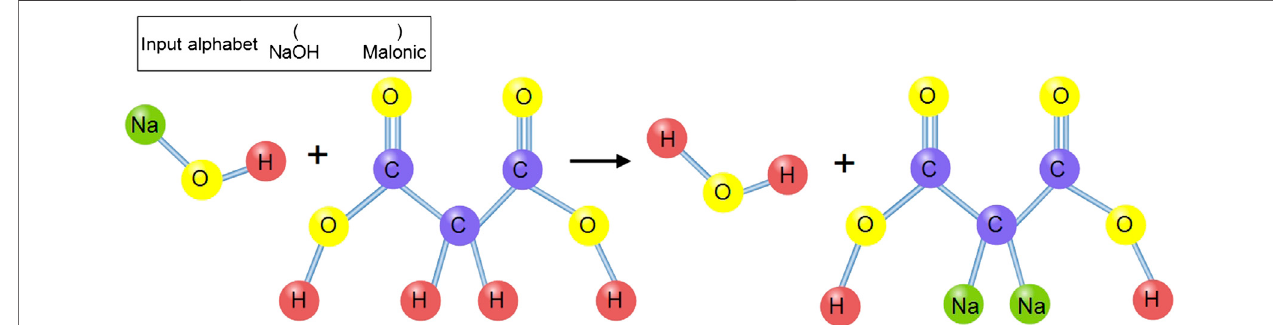
FIGURE 5 | Illustration of the acid/base reaction of L 2